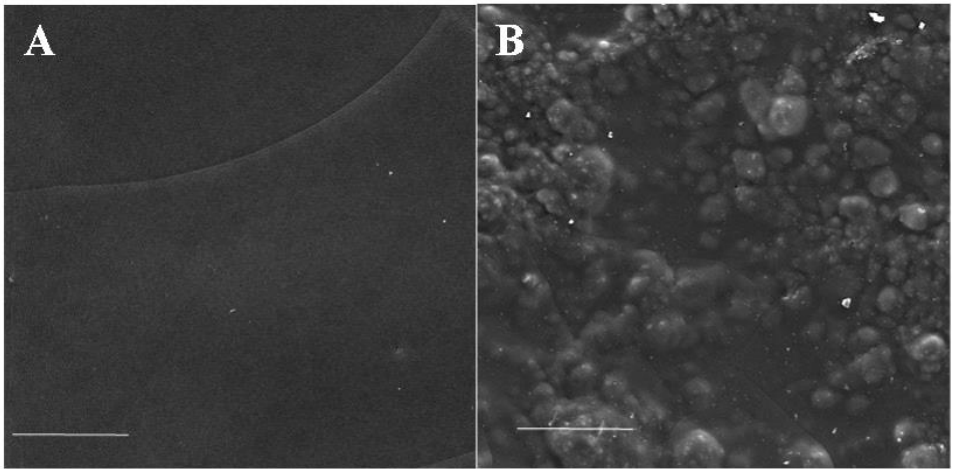
Figure 3. Image of the surface of scaffold samples obtained by scanning electron microscopy. ( A ) SF scaffold, ( B ) SF-MP scaffold. Scale bar — 10 µm.